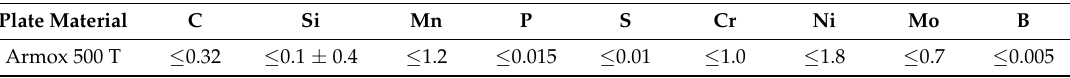
Table 1. Chemical composition of Armox 500 T armor-grade